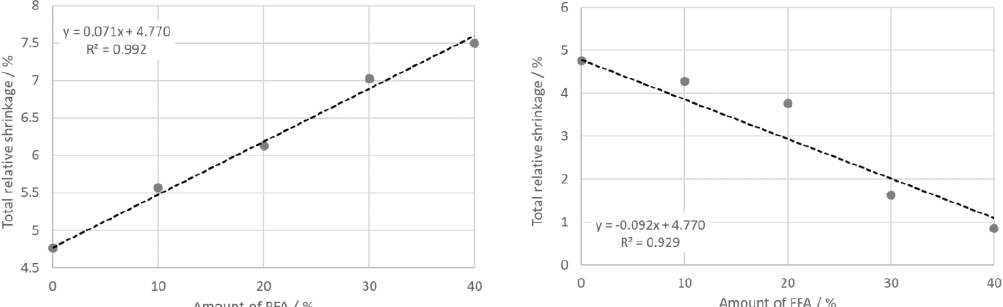
Figure 5. Total relative shrinkage of PF ( left ) and FF ( right ) samples (measured at the room temperature after firing at 1100 °C).